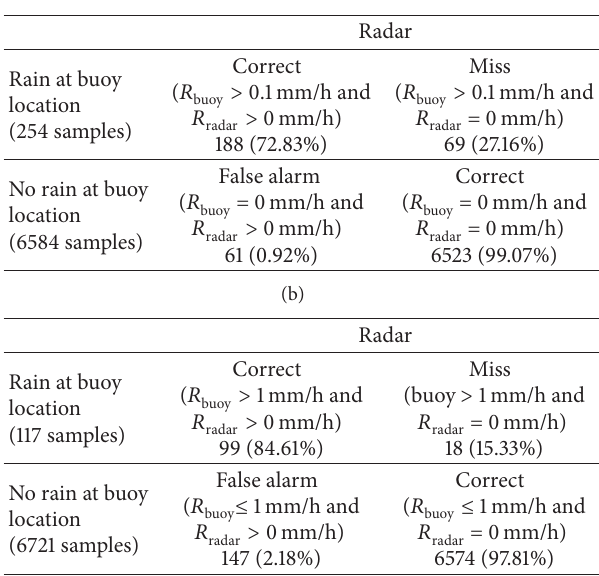
Table 1: Contingency table for the thresholds of (a) 0.1 mm/h and and 𝑅 are the hourly cumulative rainfall mea- (b) 1mm/h. 𝑅 buoy radar sured by the rain gauge installed on the “ODAS Italia 1” buoy and estimated by radar,